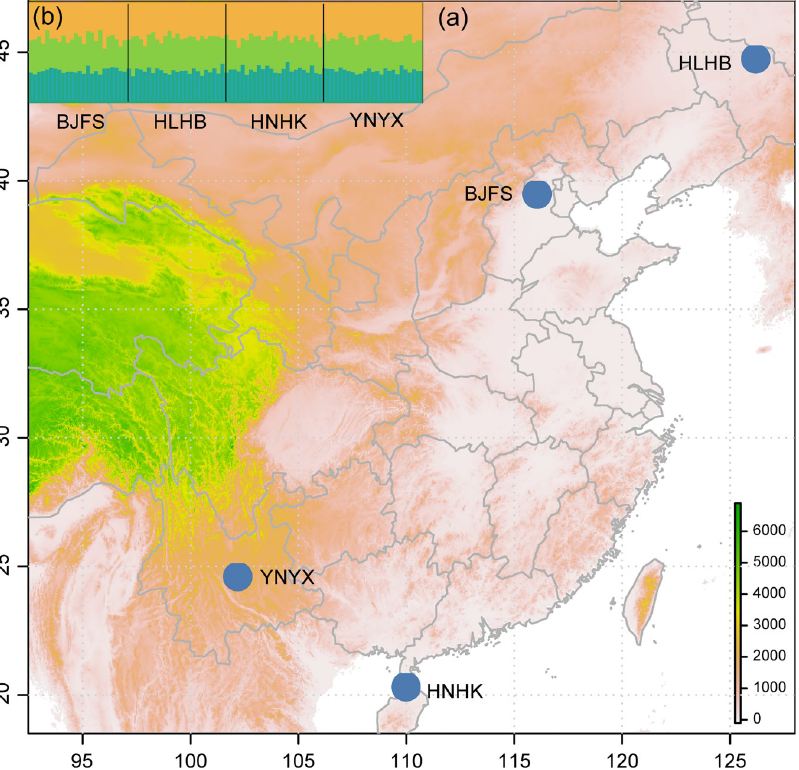
Fig 1. Collection sites of Eupeodes corollae (a) and population genetic structure analysis of four geographical populations using BAPS (a) and STRUCTURE (b). The map was drawn in R function map _ data . BAPS analysis showed that all population are clustered into one cluster (blue color in figure a). STRUCTURE analysis showed that the optimal delta K was three and all populations were composed of the three clusters. Codes for the population are shown in Table